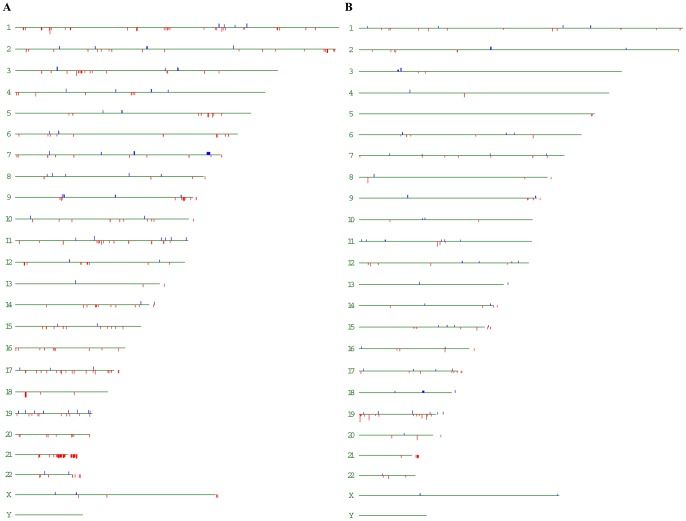
Chromosomal distribution of the differentially expressed genes.(A) and (B) indicate the chromosomal distribution of the 174 and 383 differentially expressed transcript clusters in N and C group between DS and age-matched controls, respectively. Blue bars represent lower expressed genes and red bars represent higher expressed genes in DS individuals.